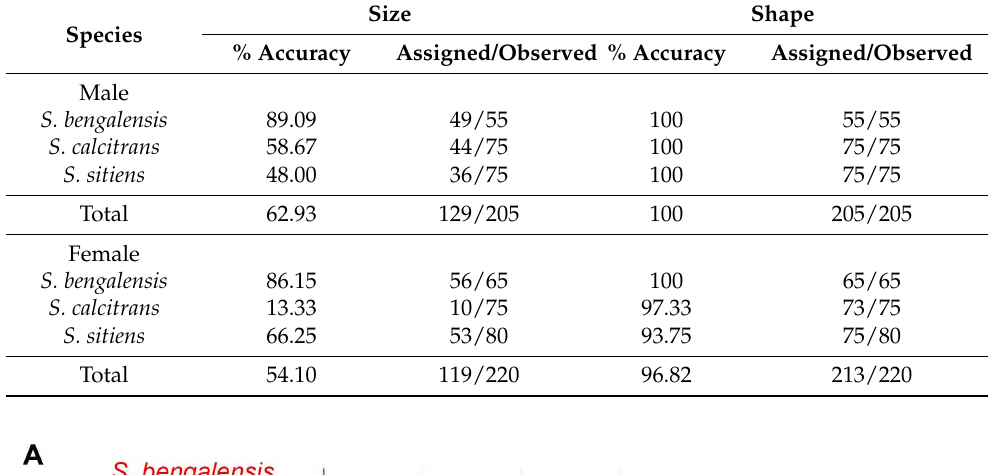
Table 4. Cross-validated classification based on the wing sizes and wing shapes of male and female Stomoxys bengalensis , S. calcitrans , and S. sitiens .